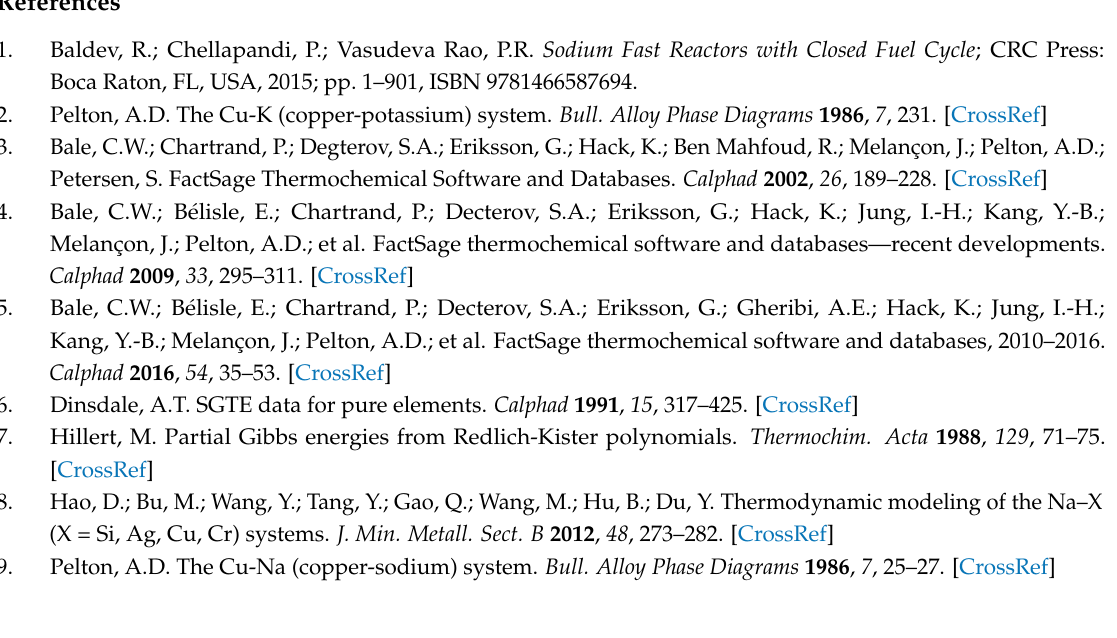
Figure S1: General view of the calculated phase diagram of the Cu-K system. Figure S2: Isothermal section at 270 K of the calculated phase diagram of the Cu-Na-K ternary system. Figure S3: Isothermal section at 300 K of the calculated phase diagram of the Cu-Na-K ternary system. Figure S4: Calculated liquidus surface projection of the Cu-Na-K ternary